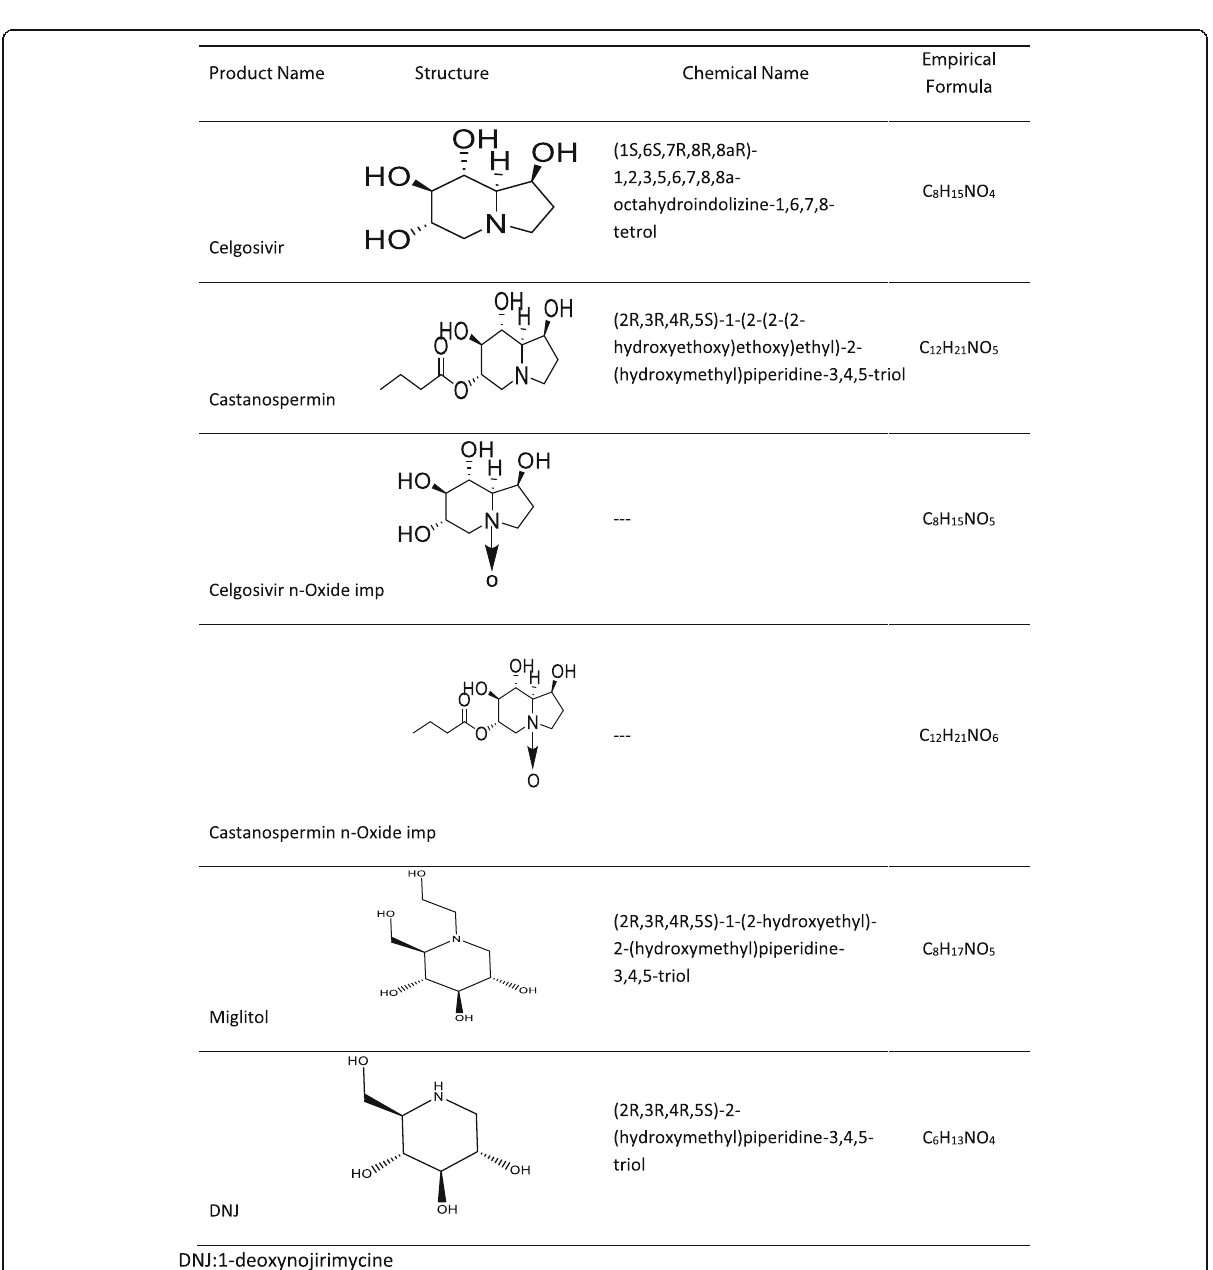
Fig. 14 Selected Aza sugars product names, structures, chemical names, and empirical